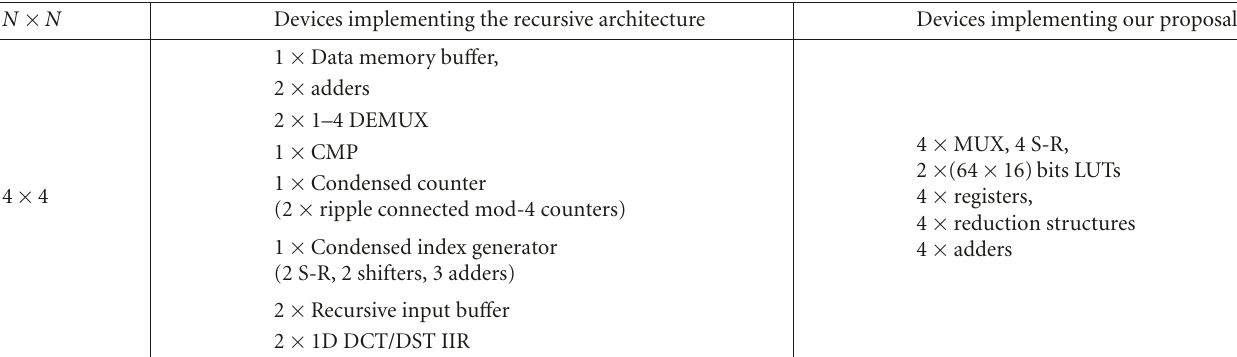
Table 16: Comparison between the hardware needed by the recursive architecture versus that of the implementation of our proposal for 4 × 4 DCT